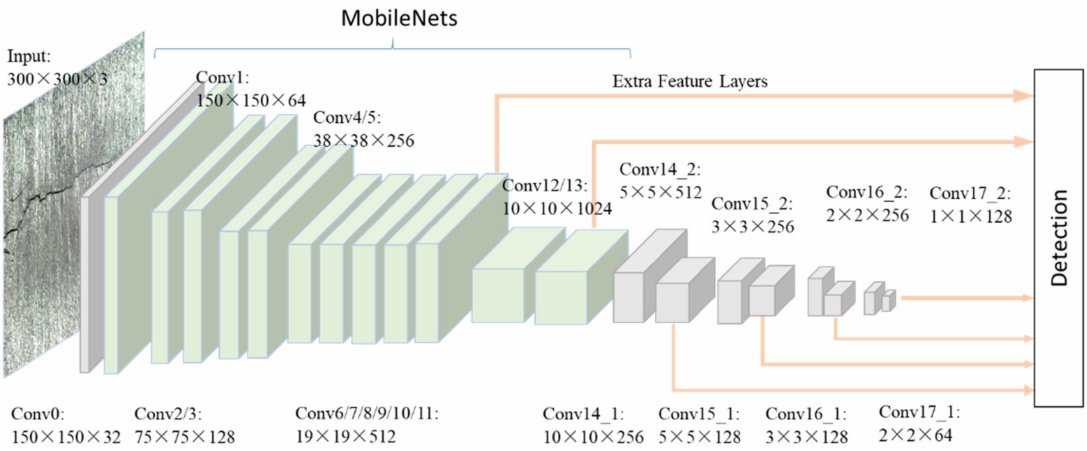
Figure 2. The architecture of the CNN for crack area location.